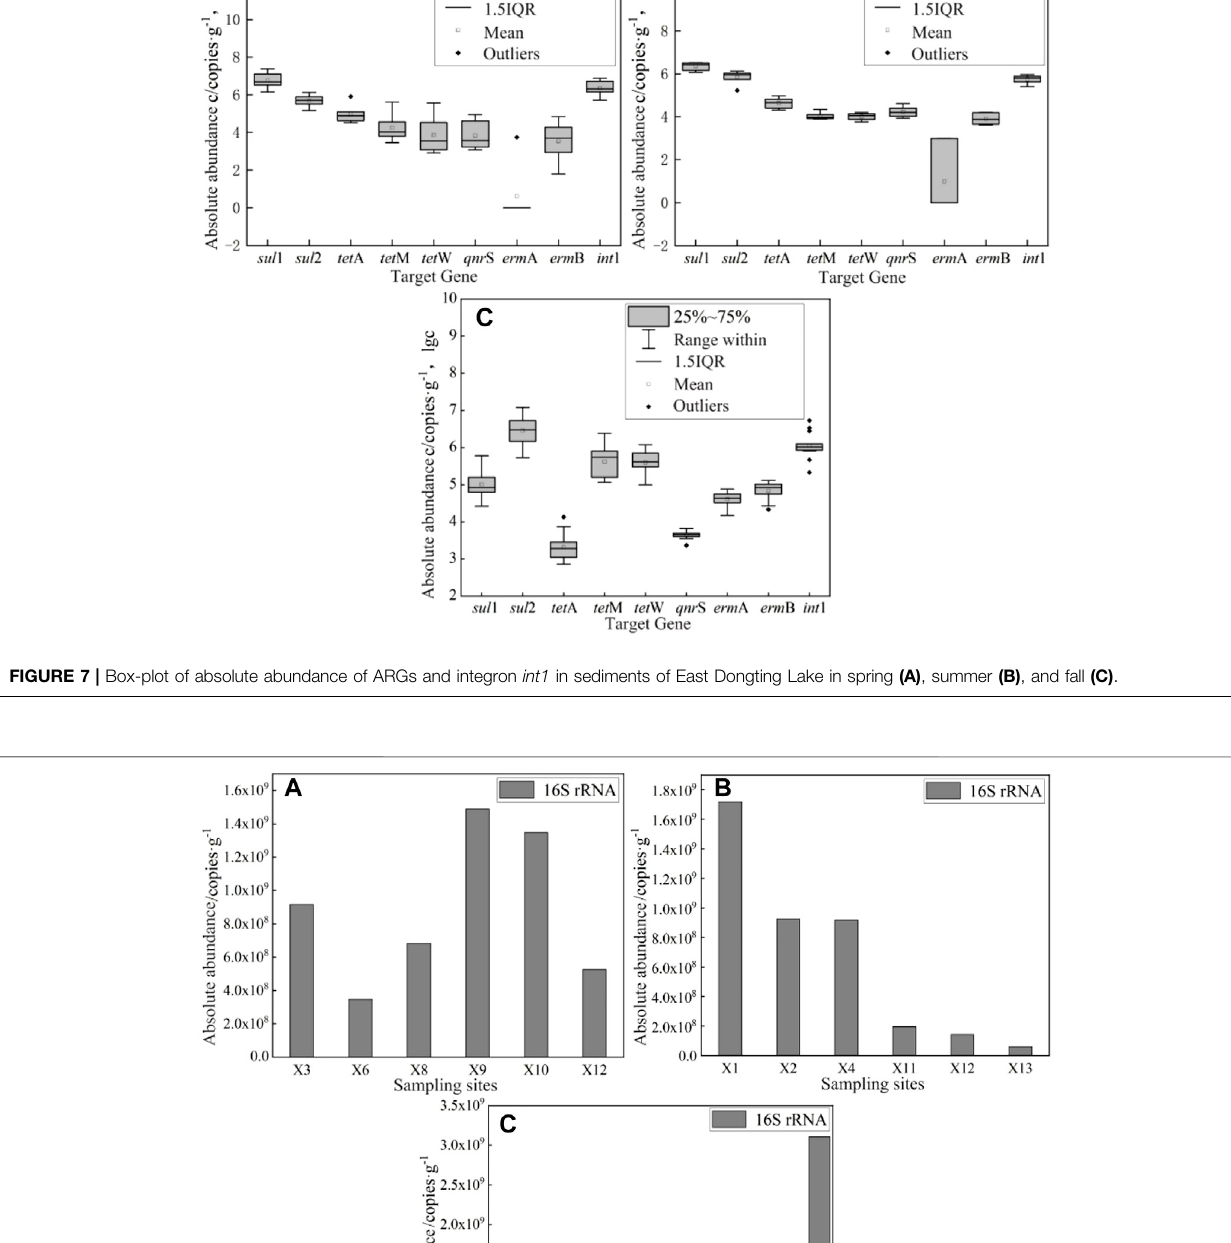
Frontiers in Environmental Science |